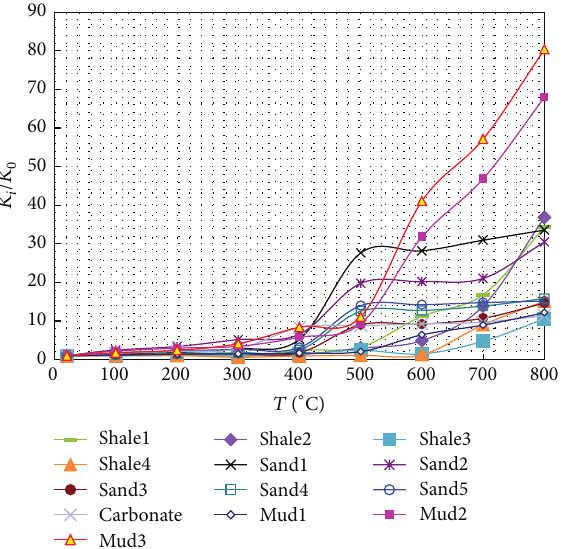
Figure 5: Normalized permeability as a function of treatment tem- perature for all the samples.